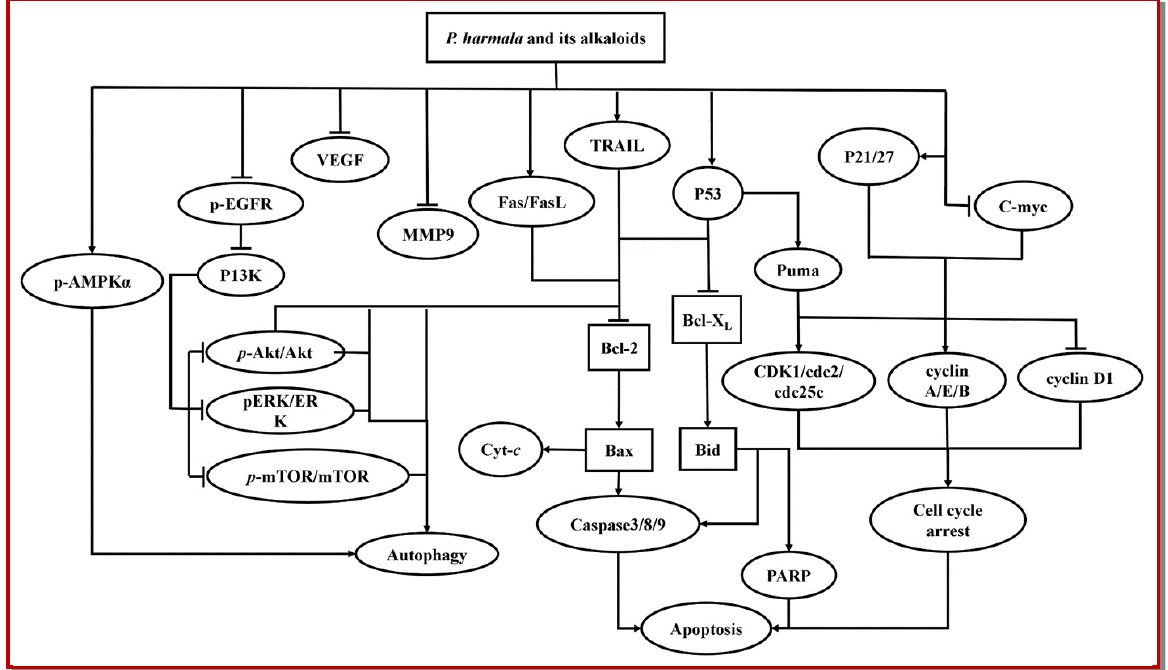
Figure 1: The reported anti-cancer mechanisms of P. harmala and its